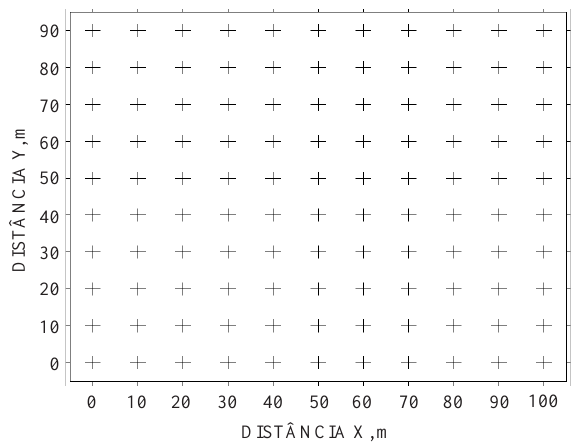
Figura 1. Esquema de